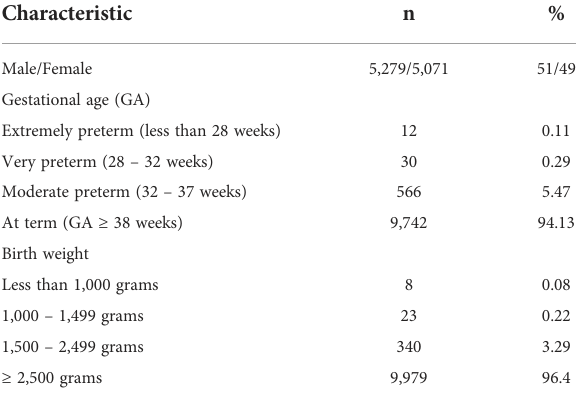
TABLE 1 Baseline characteristics of the screened